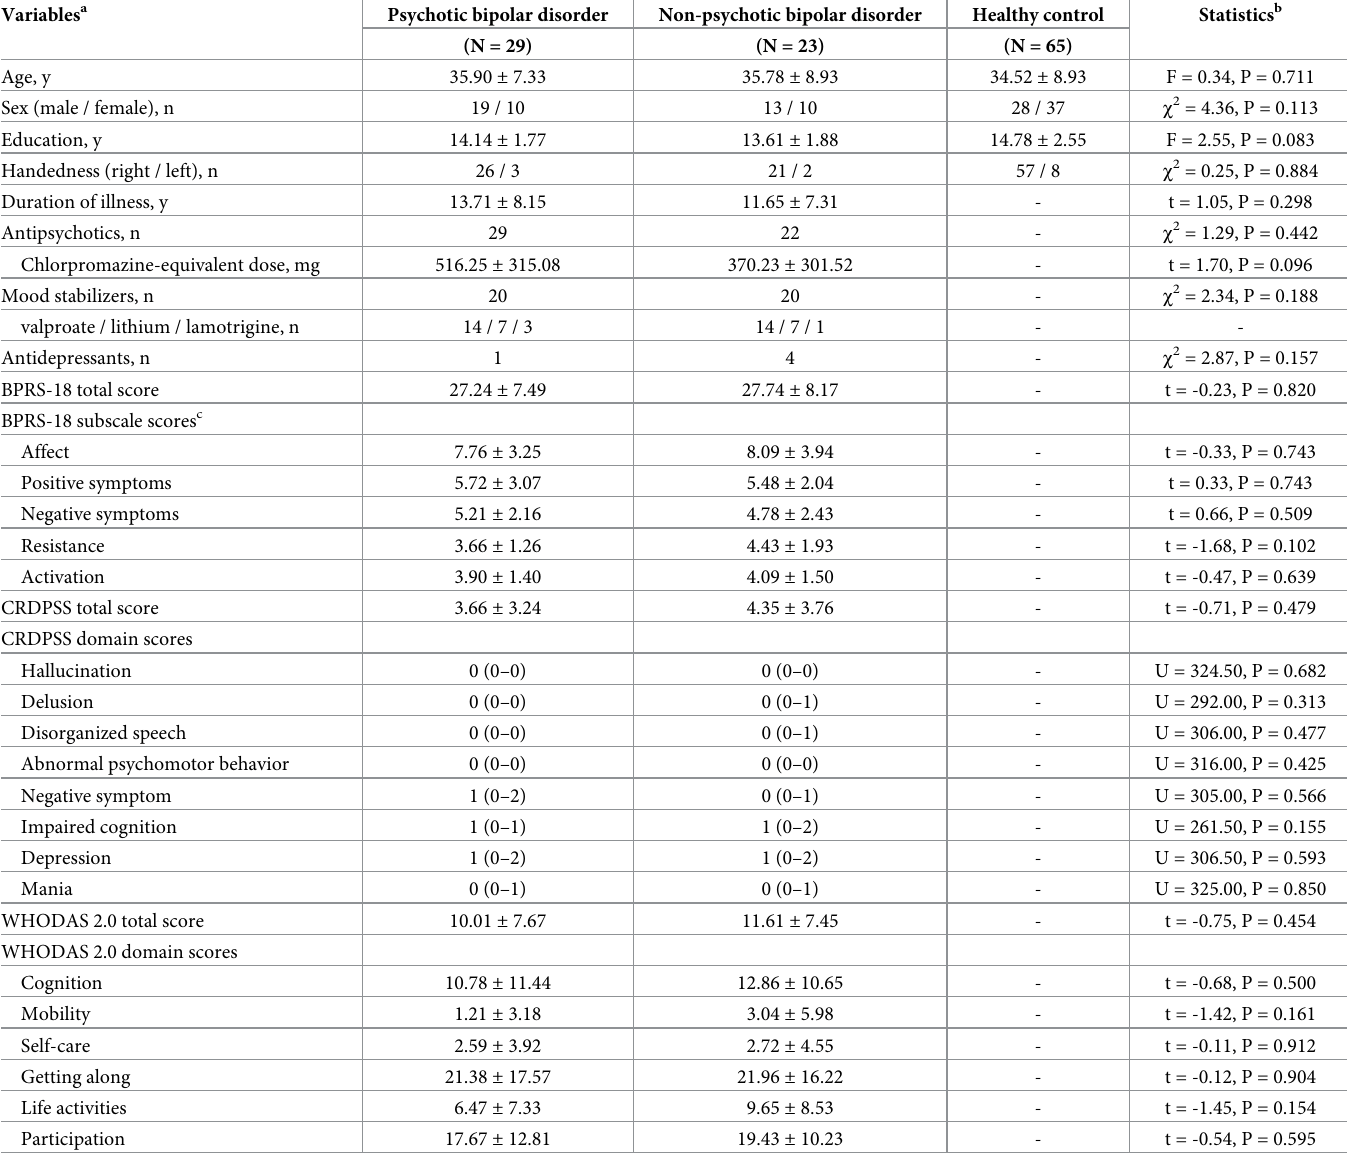
Table 1. Demographic and clinical